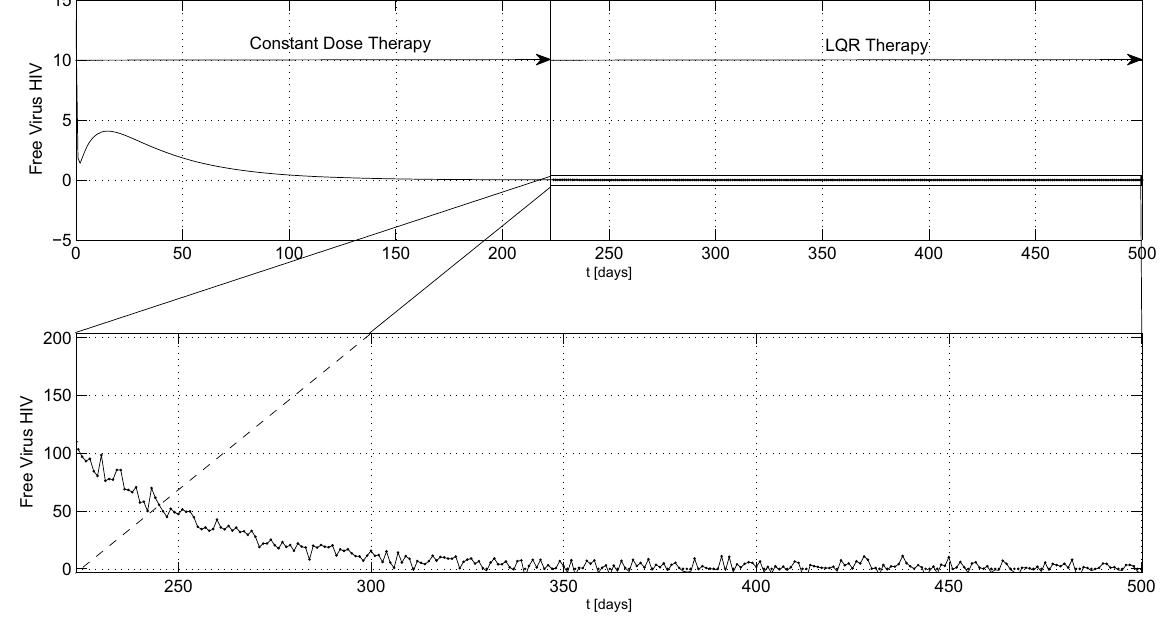
Fig. 2 – The number of viruses HIV is kept at adequate low level under LQR control.